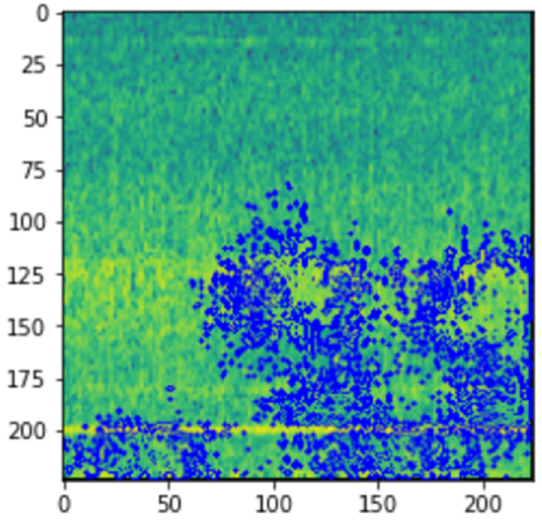
Figure 19. LIME image explainer on healthy vibrational signal.